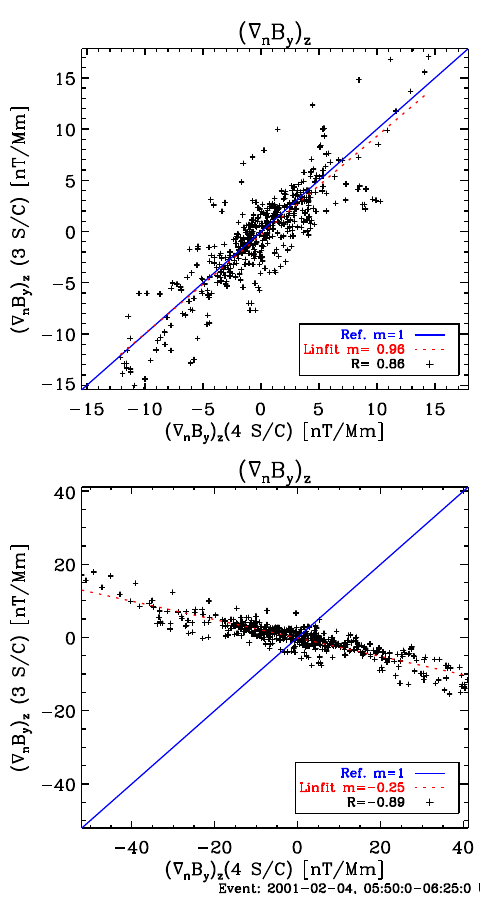
Fig. 4. Same as Fig. 3 but based on the geometric constraint ∇ B y ⊥ ˆ e (instead of ∇ B y k ˆ e